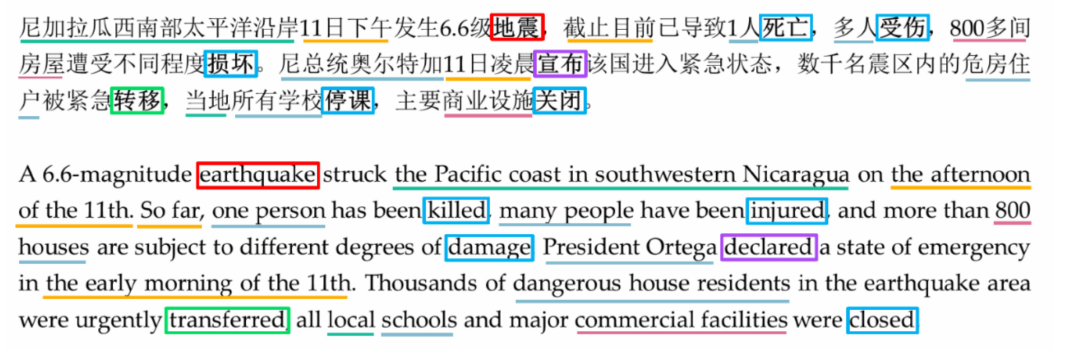
Figure 7. An example of CEC